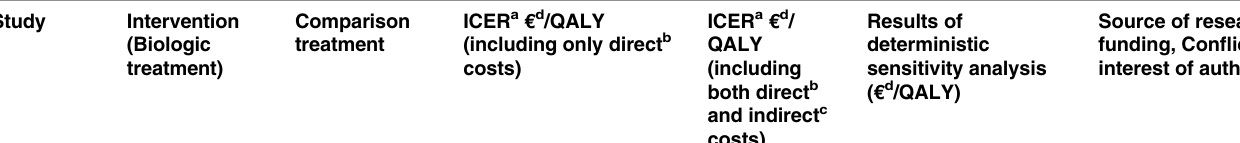
Table 3. Cost-effectiveness of biologics for the treatment of ulcerative colitis